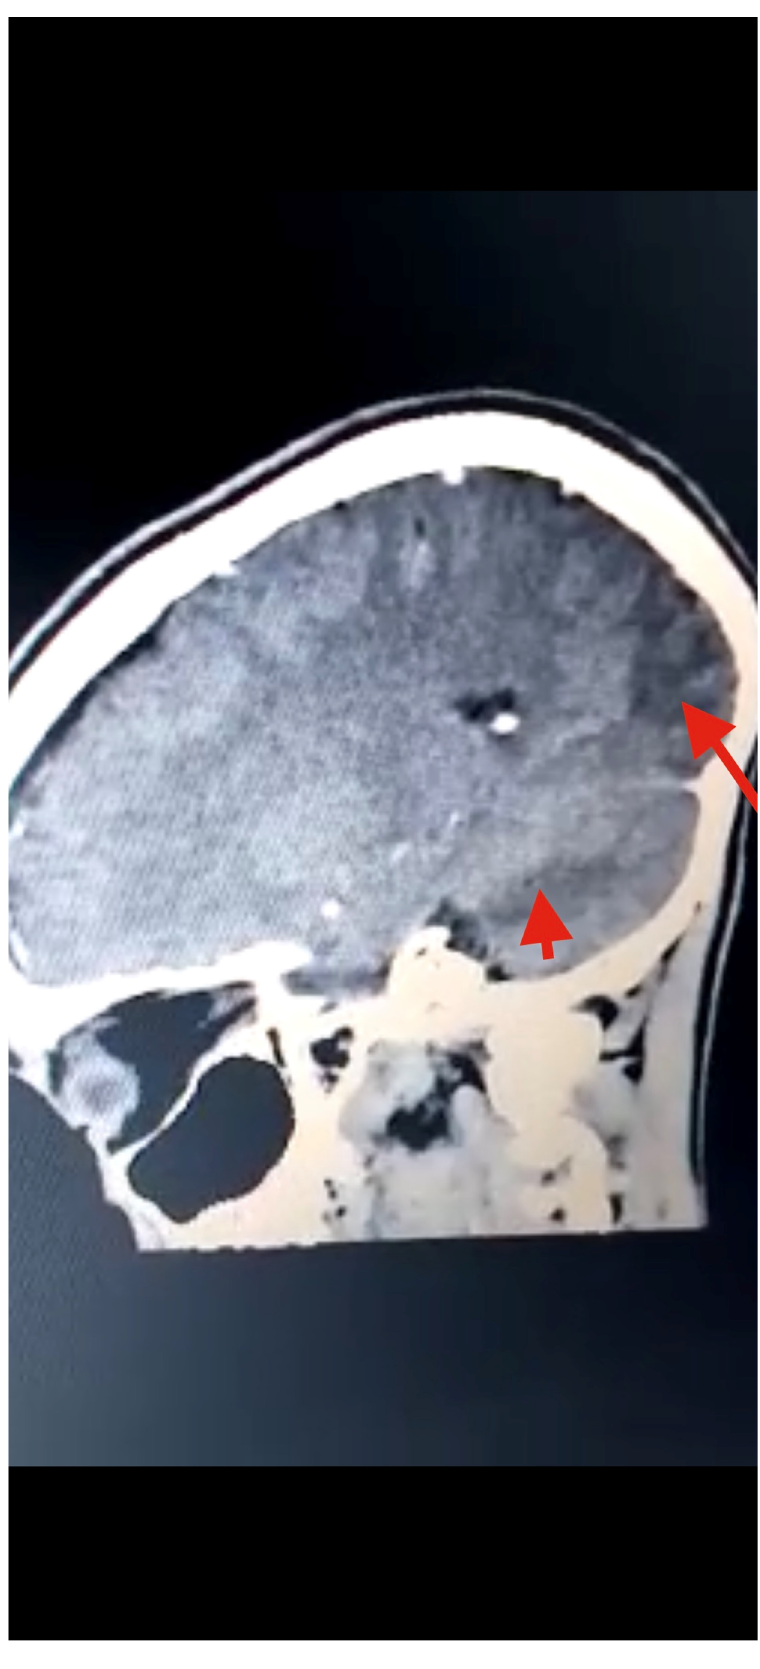
Figure 3. Head CT scan showing multiple T1W hypointense, with T2W and FLAIR hyperintense, areas in the posterior and parietal cortices, indicative of infarction (red arrows) due to stroke from cysticercal invasion of the vascular bed.